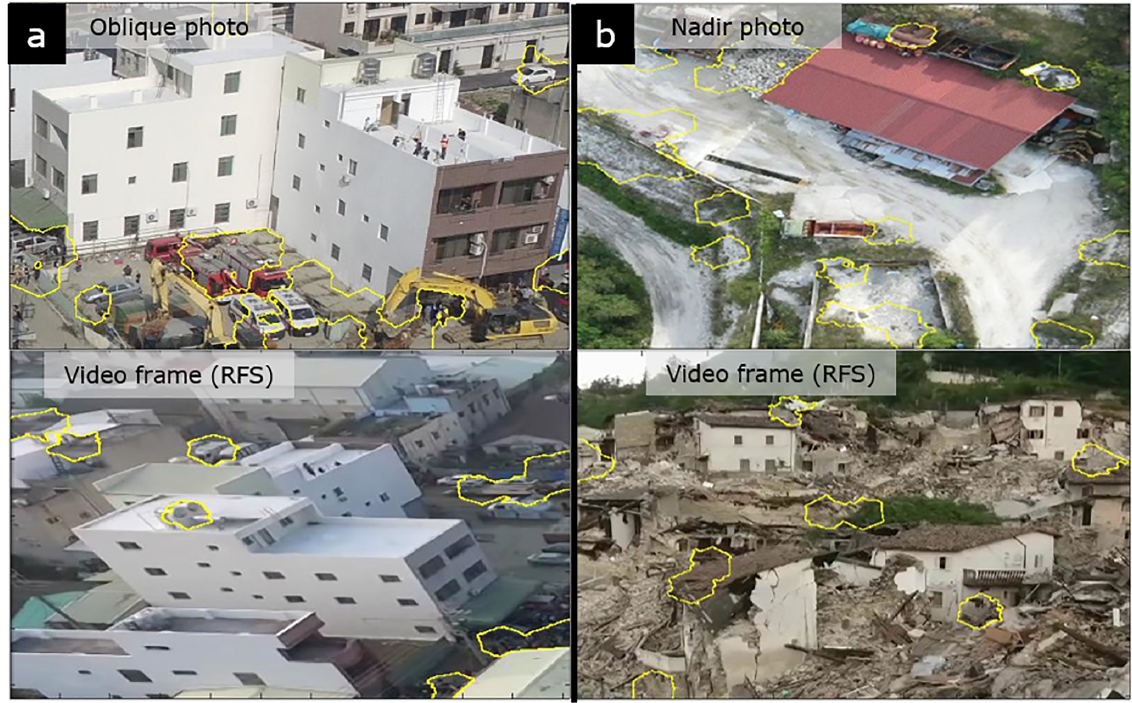
Figure 5. Extraction of 2-D damage-related features using different datasets. Polygons: false positives in the extraction of 2-D damage- related features for (a) Tainan oblique photo and video frame (random frame selection, RFS) and (b) Pescara del Tronto nadir photo and video frame (RFS).